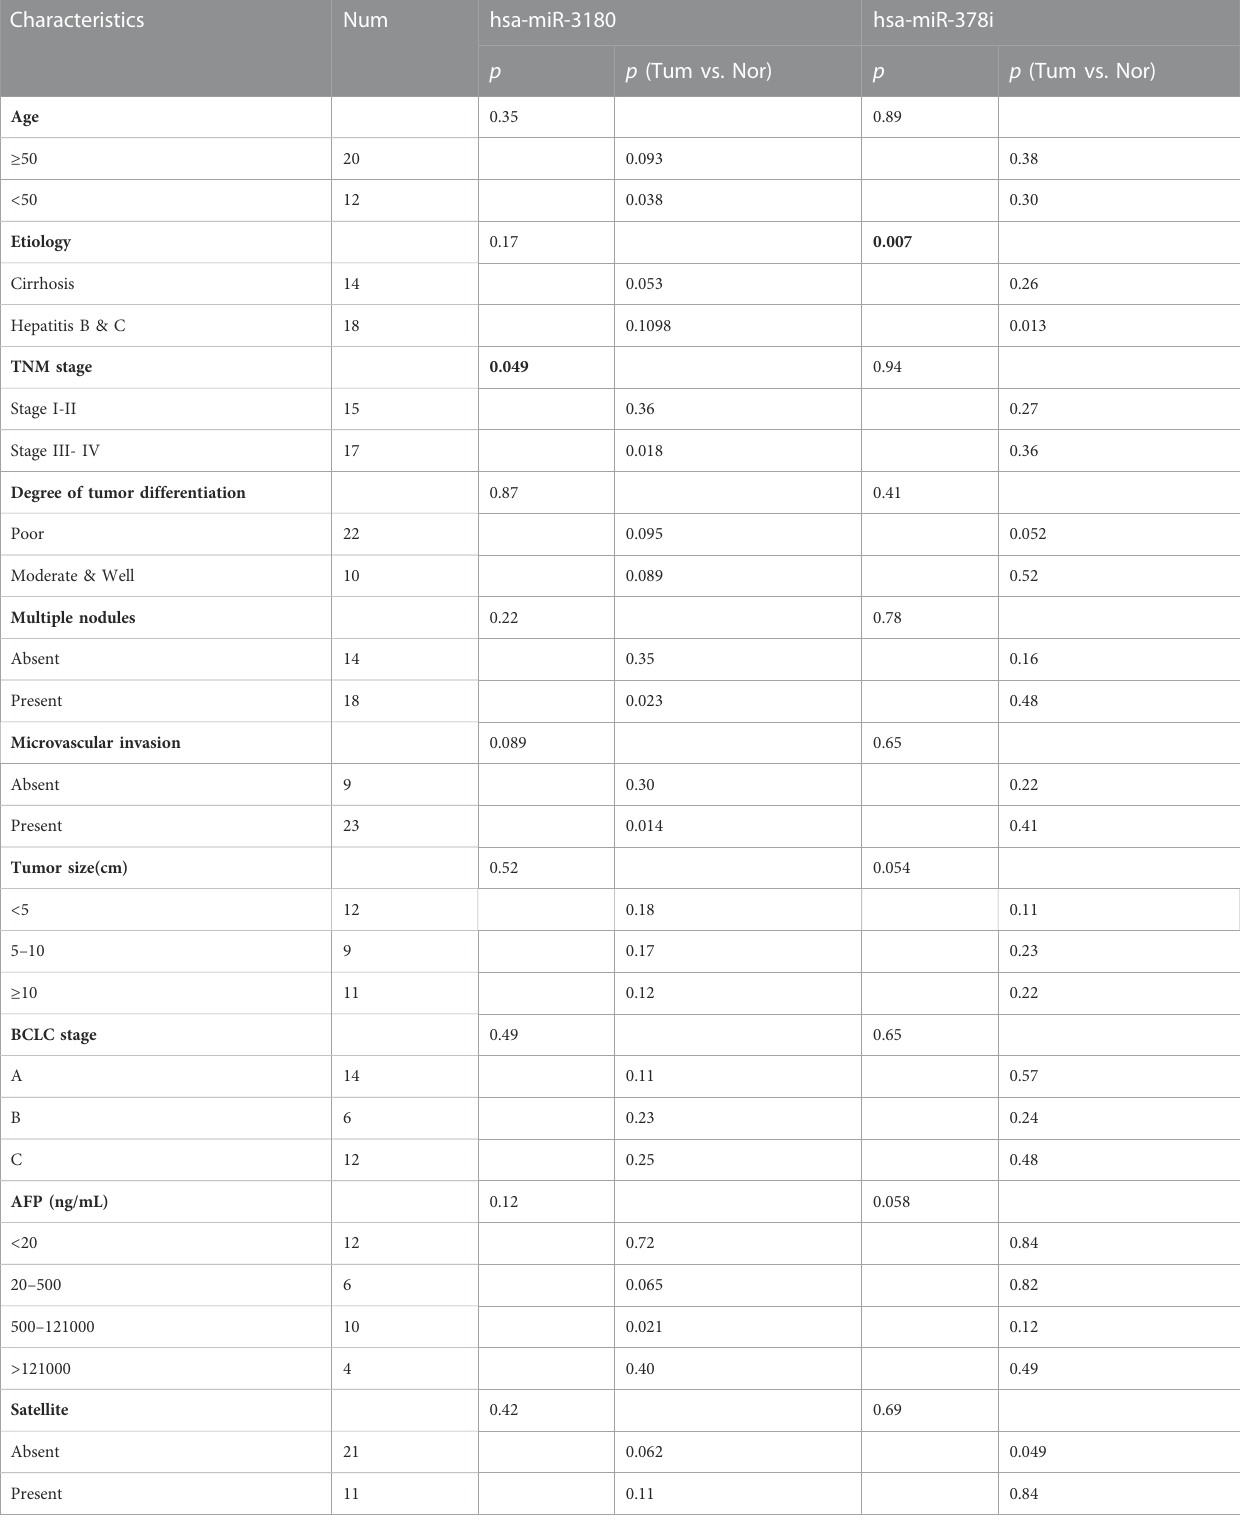
TABLE 2 Clinicopathological patient characteristics and hsa-miR-3180 and hsa-miR-378i expression in HCC tissues.